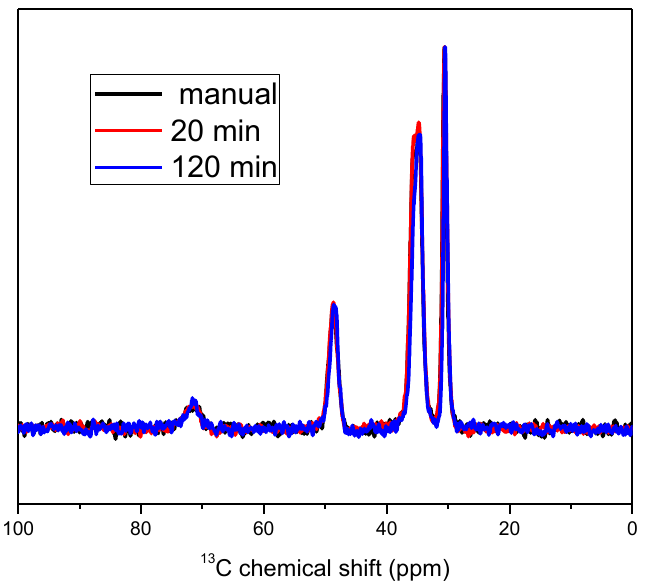
Figure 6. 13 C MAS NMR spectra of the reaction mixture applied in Ref. [46]: milled for 120 min, 20 min and manually ground.